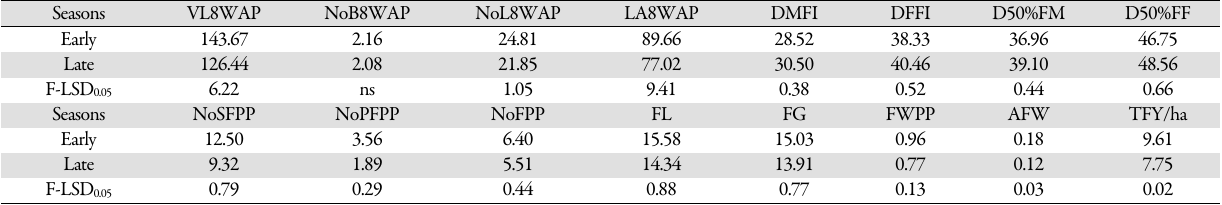
Table 5. Seasonal performance of cucumber genotypes with respect to some vegetative and yield traits evaluated in 2014 planting